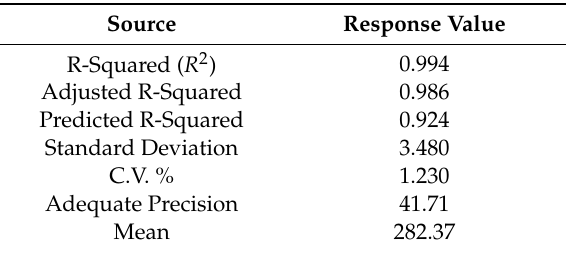
Table 5. Statistical data from ANOVA for tensile strength.